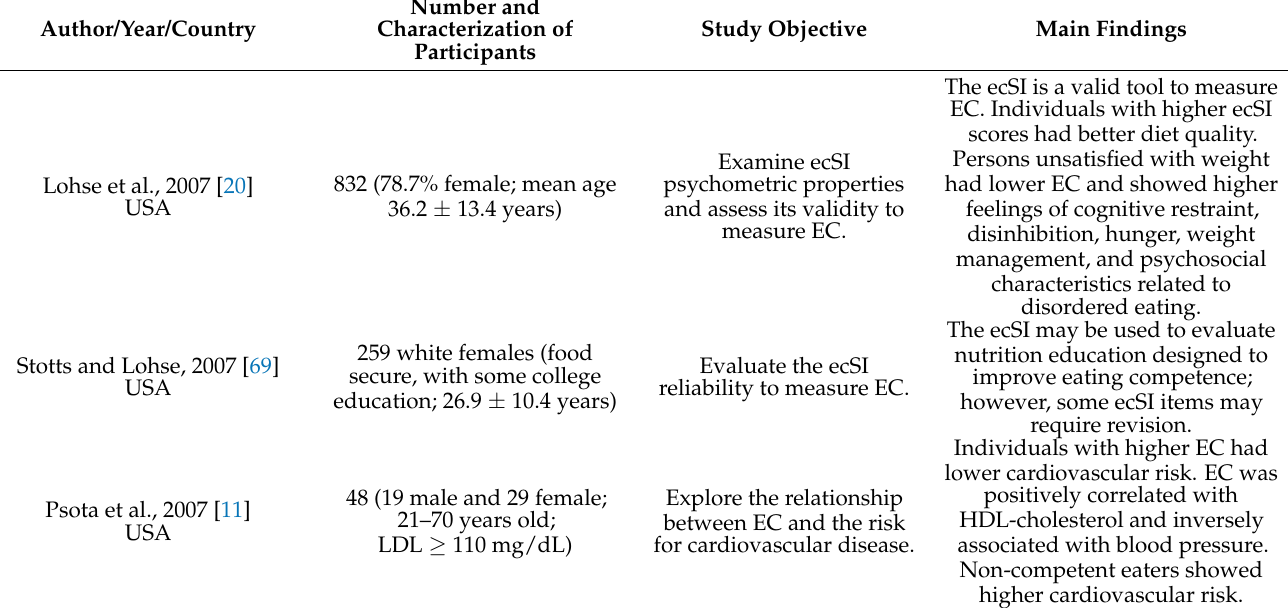
Table 1. Characterization of the studies that evaluated eating competence (EC) using the Ellyn Satter inventory (ecSI) in different